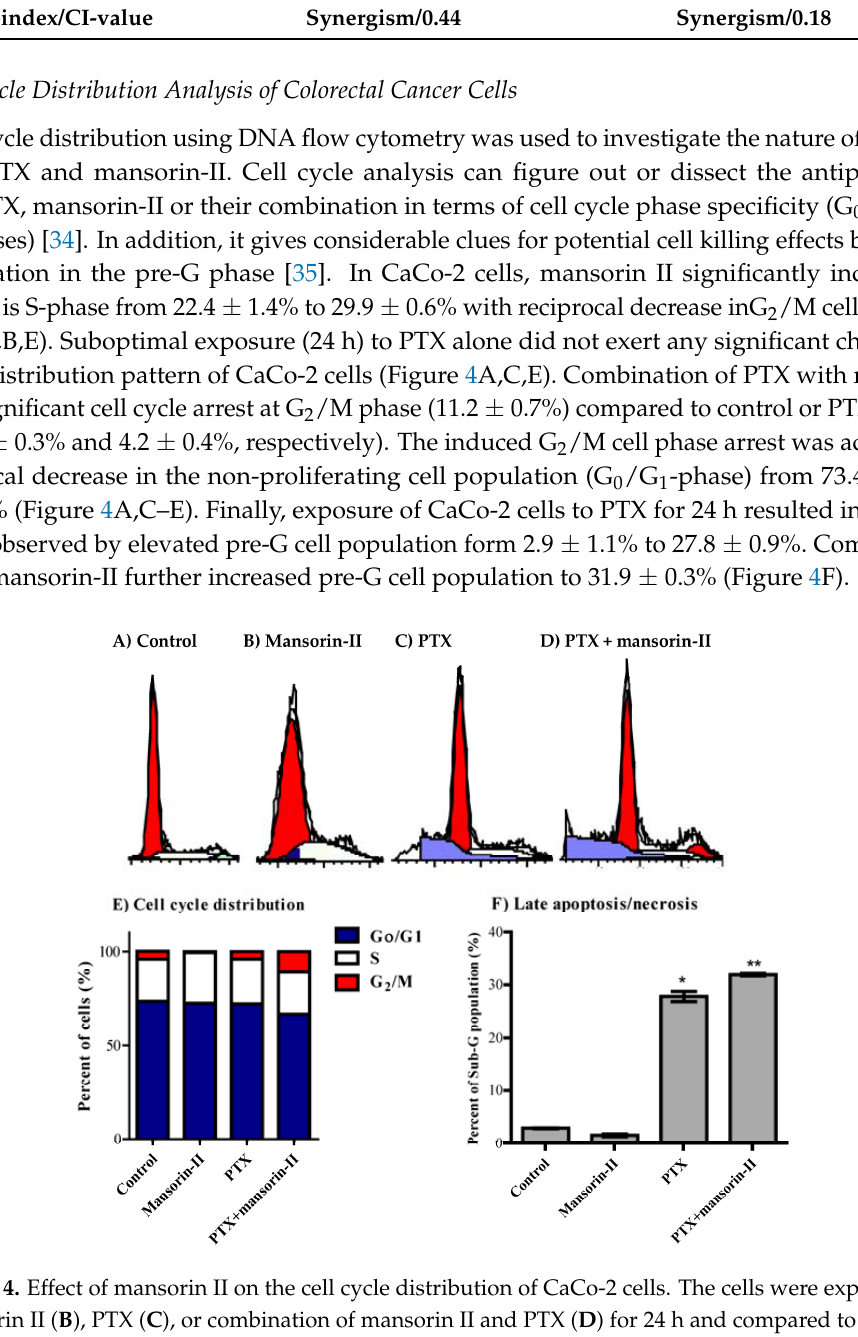
Table 2. Effect of mansorin-II on the cytotoxicity parameters of PTX in colorectal cancer cell